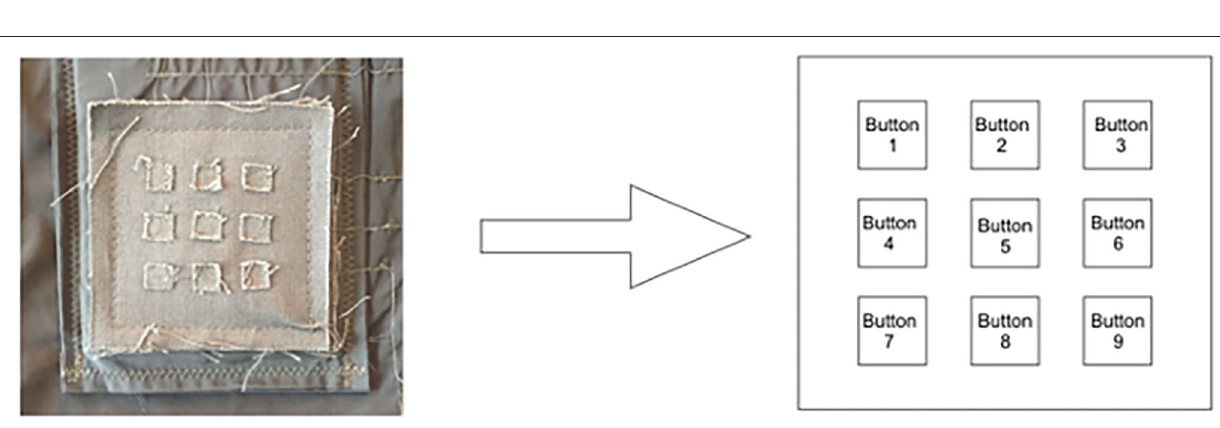
Y axes without using a stiff surface underneath the pad.